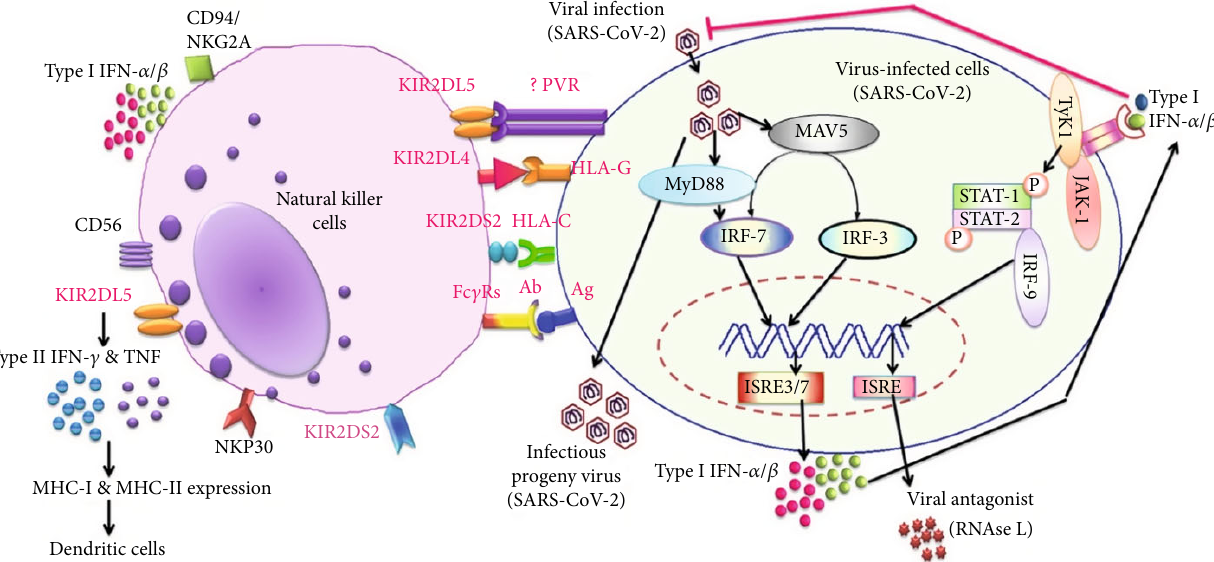
Figure 1: Schematic for KIR-HLA haplotype interaction and NK cell response in SARS-CoV-2 infection.